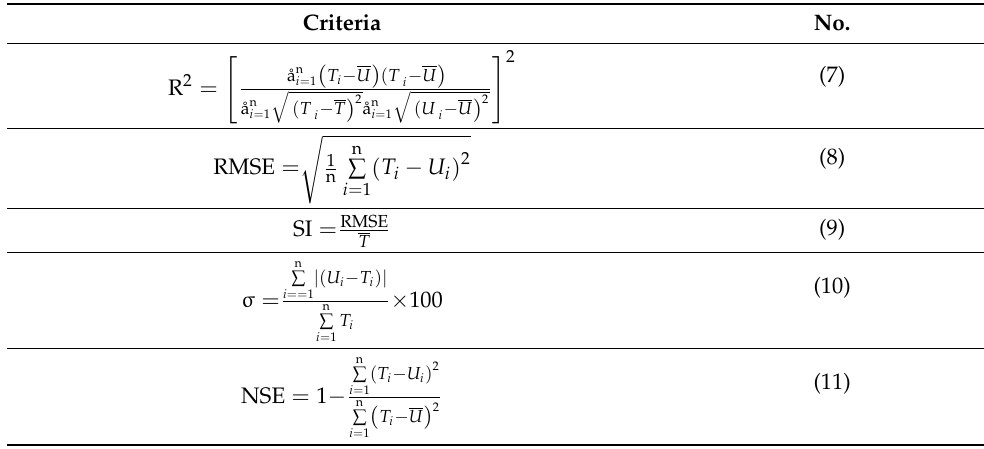
Table 5. Statistical parameters.